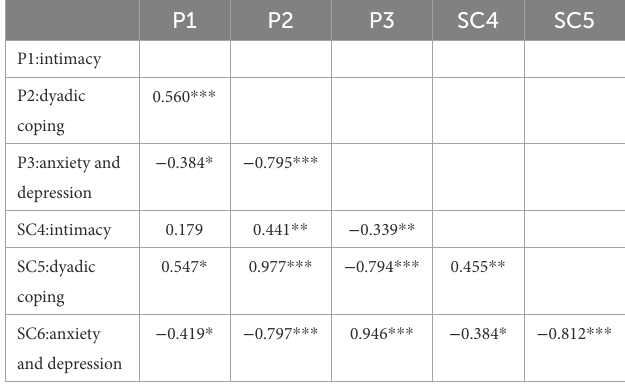
TABLE 2 Patients and spousal caregivers’ scores on variables. Patients